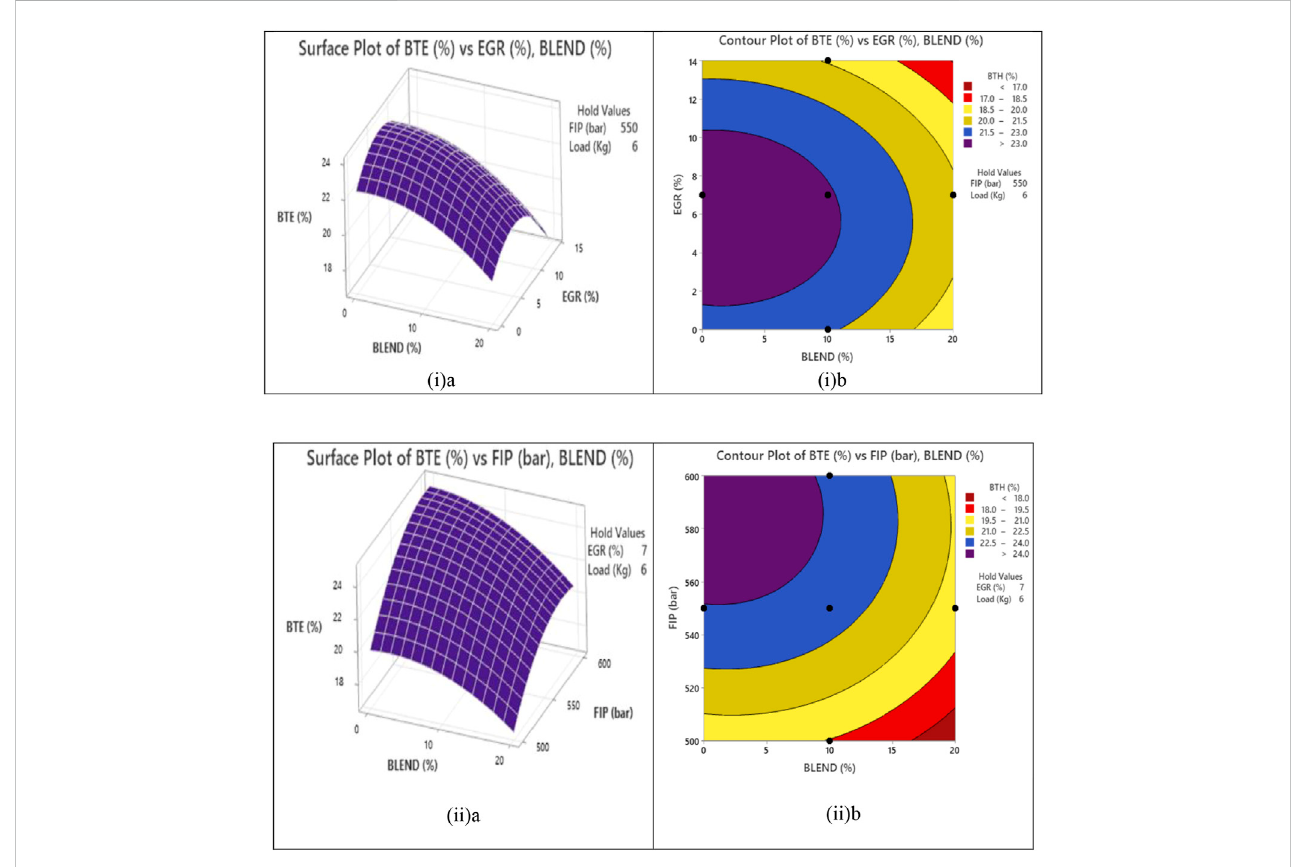
FIGURE 5 Effect of input factors on